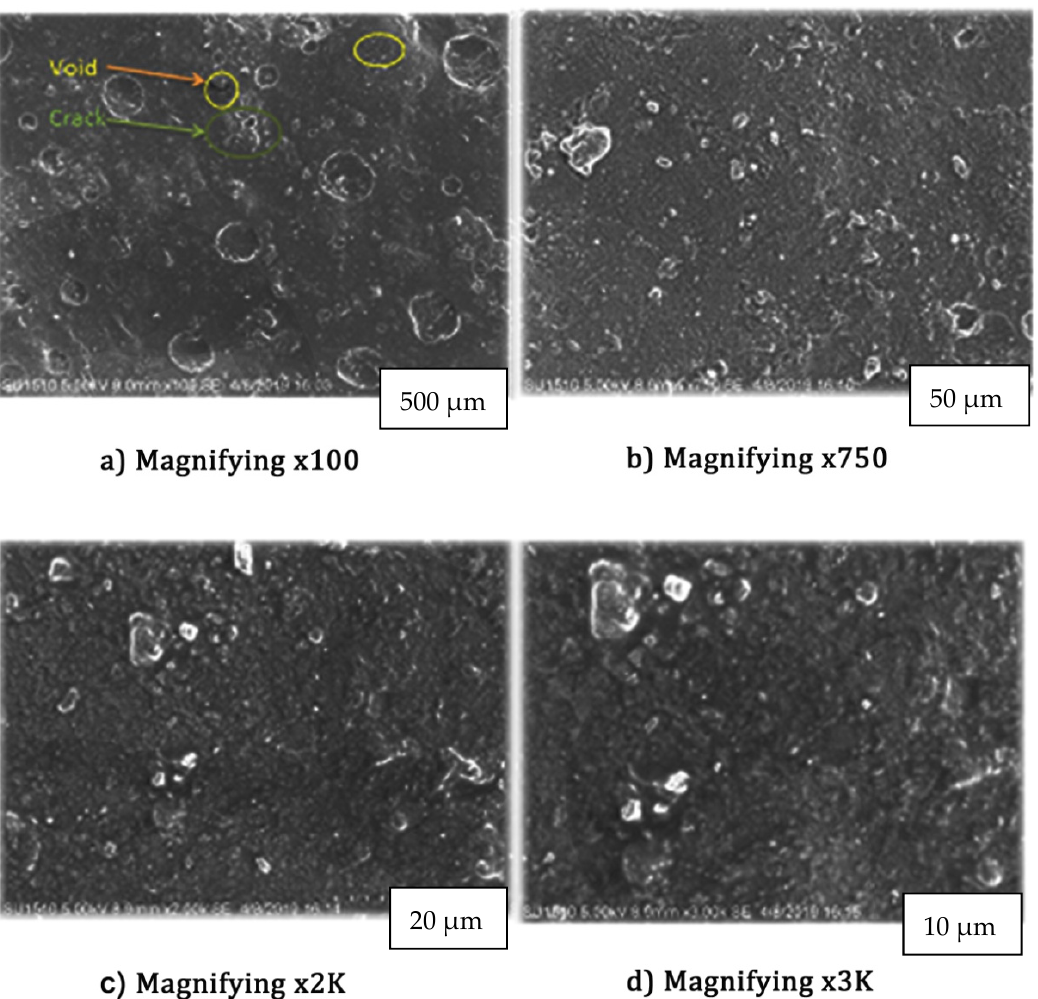
Figure 4. SEM photograph of ginger tea bioplastic at ( a ) 100×, ( b ) 750×, ( c ) 2000× and ( d ) 3000×.